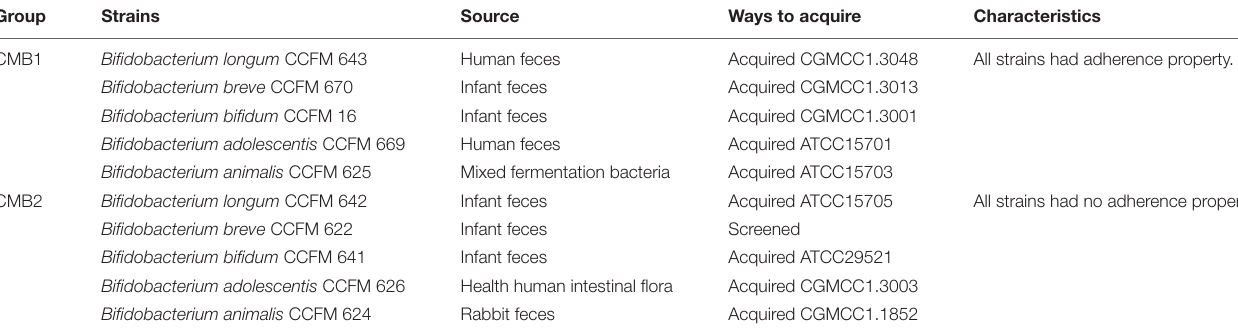
TABLE 1 | Bifidobacteria used in this